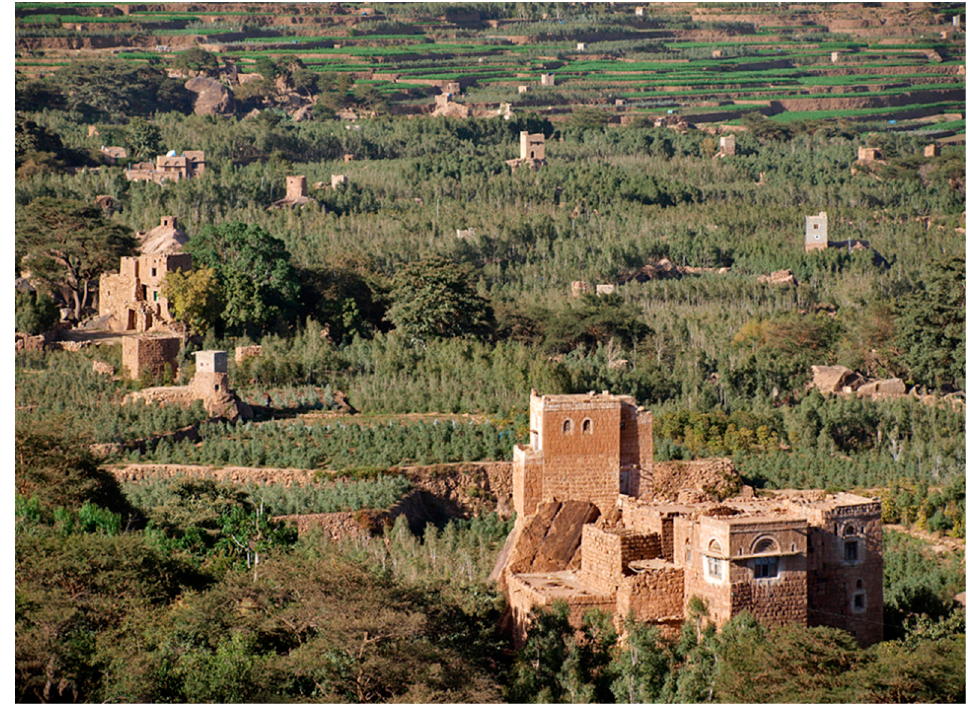
Figure 1. Qat fields in western Yemen. Photo: CC BY-SA 3.0 Antti Salonen.